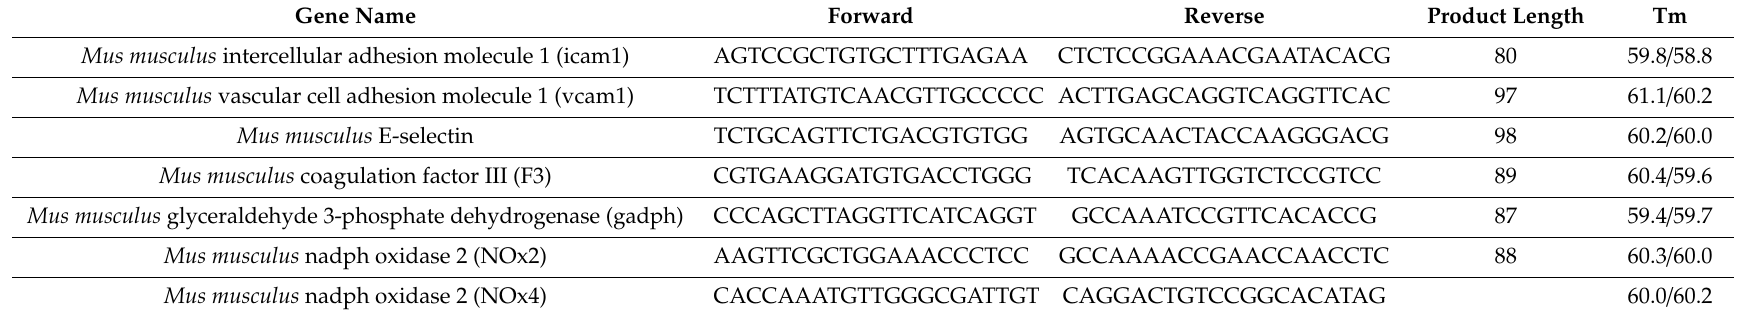
Table 1. Real-Time PCR primers